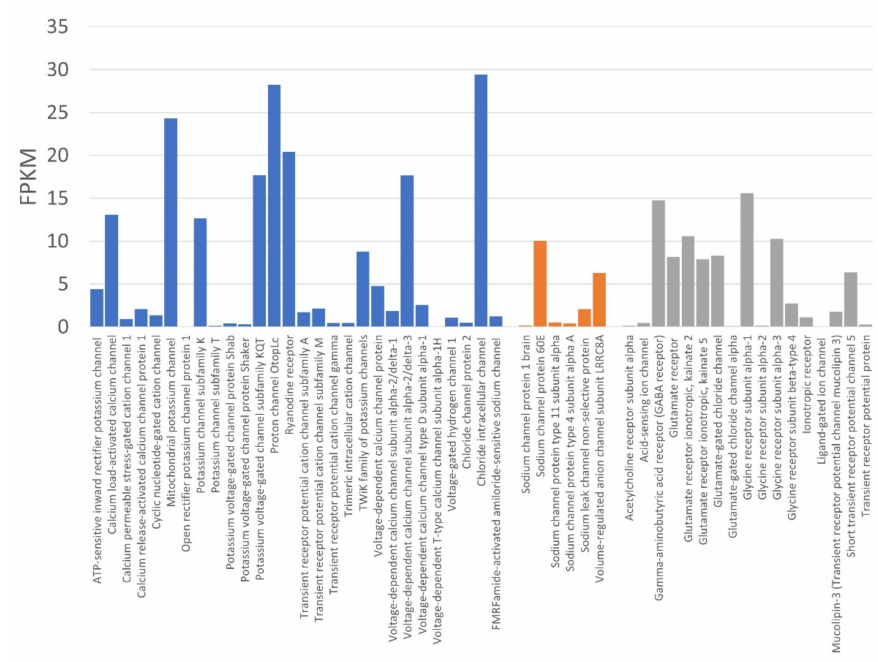
Figure 5. The expressed ion channels of the Latrodectus geometricus venom